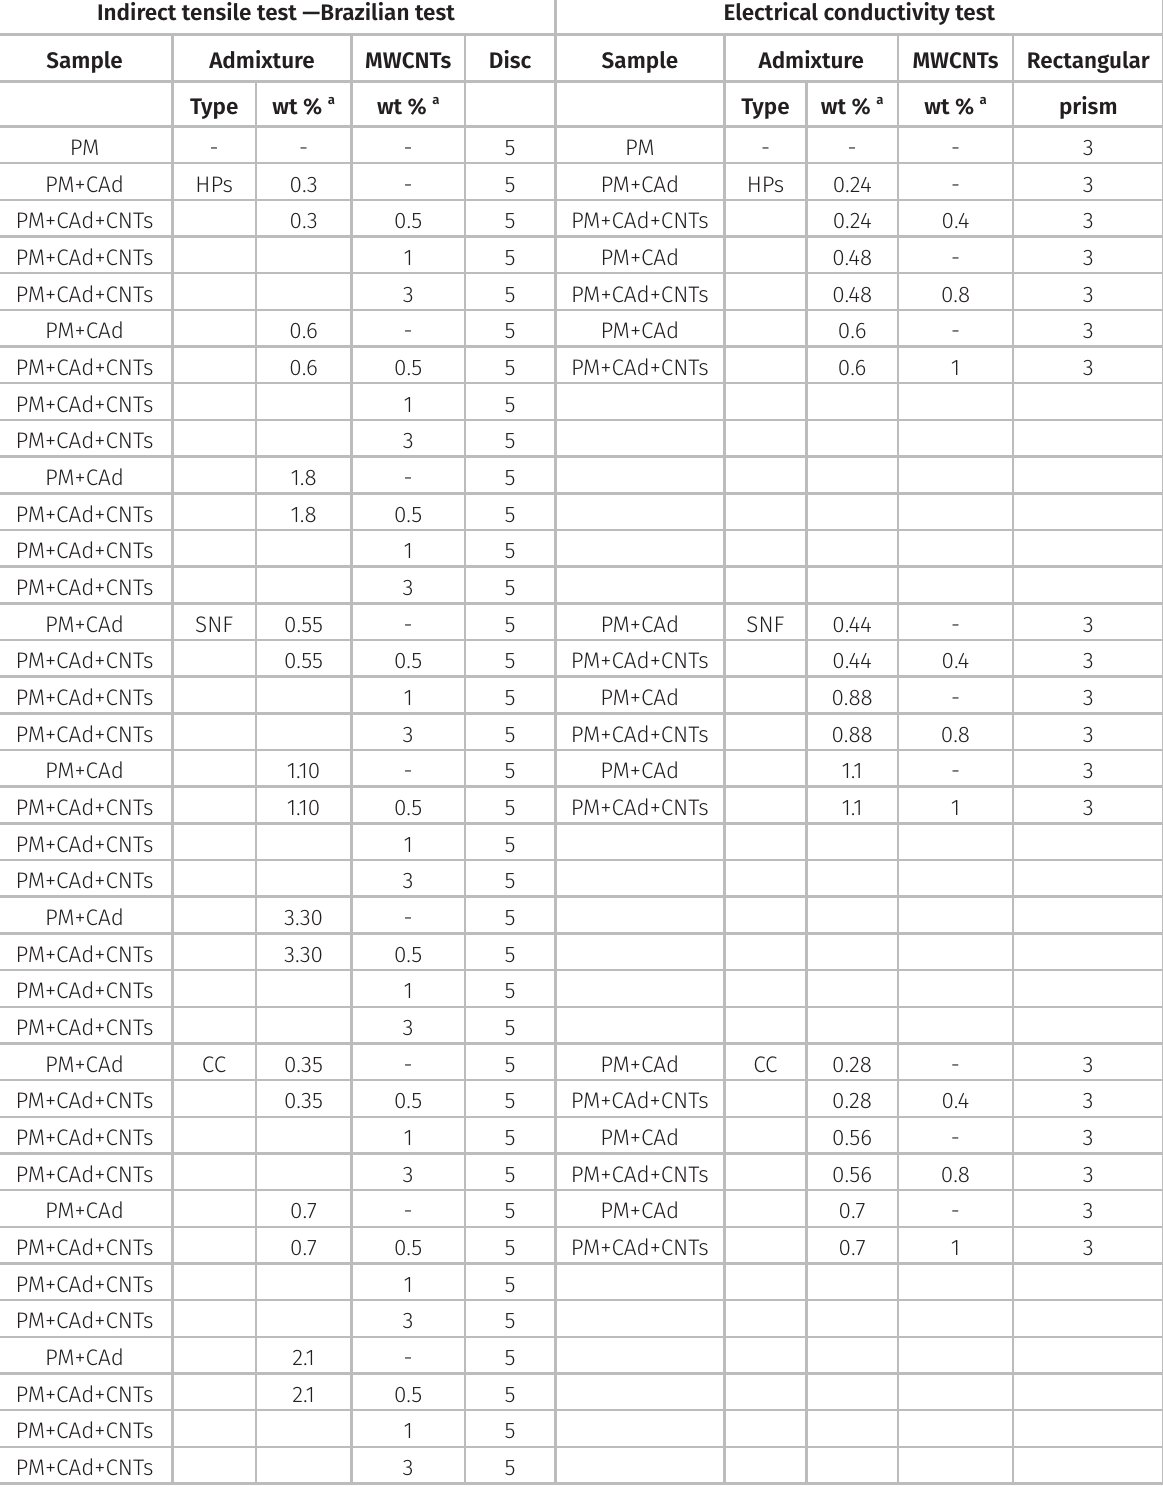
a Values expressed as a cement weight